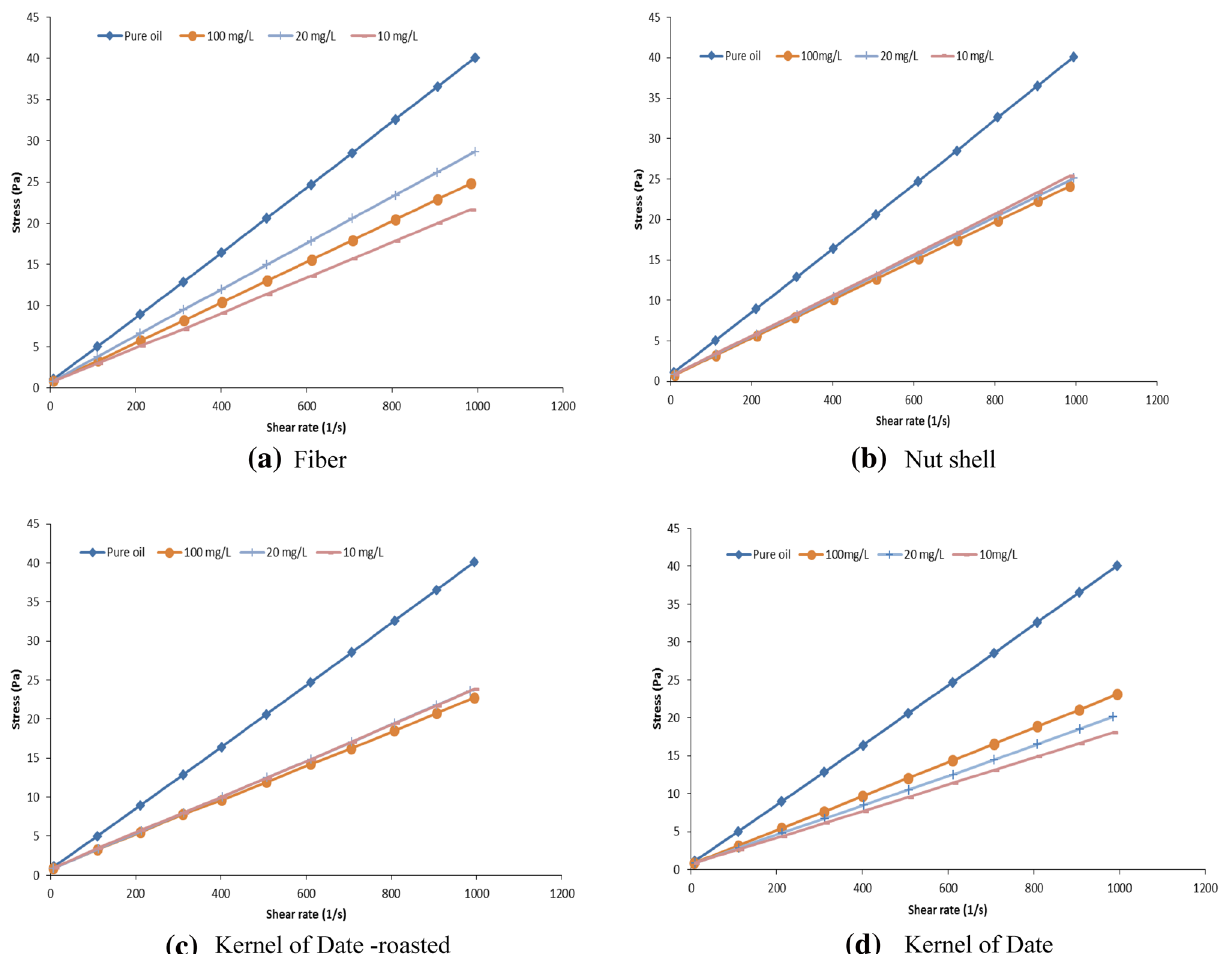
Fig. 6 Shear rate of light crude oil using bio materials (75